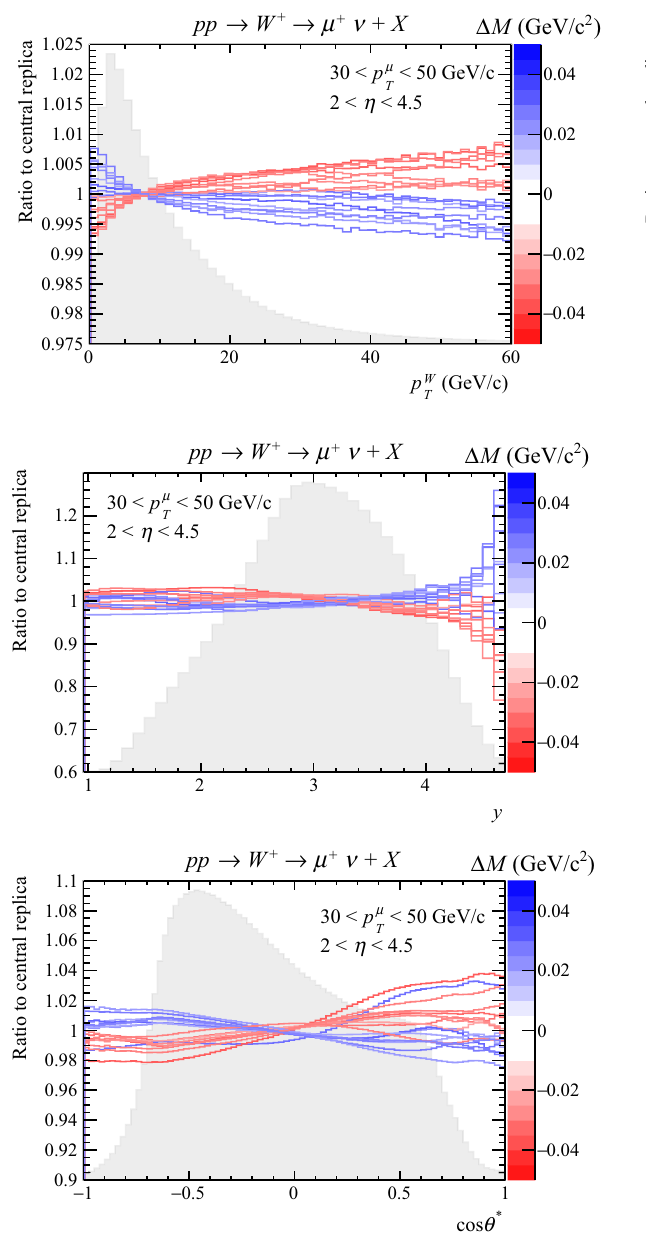
μ , y and cos θ ∗ distribu- distribution of a single toy dataset. For clarity, the replicas fit to the p T T for which the shift in M W is close to zero are not drawn